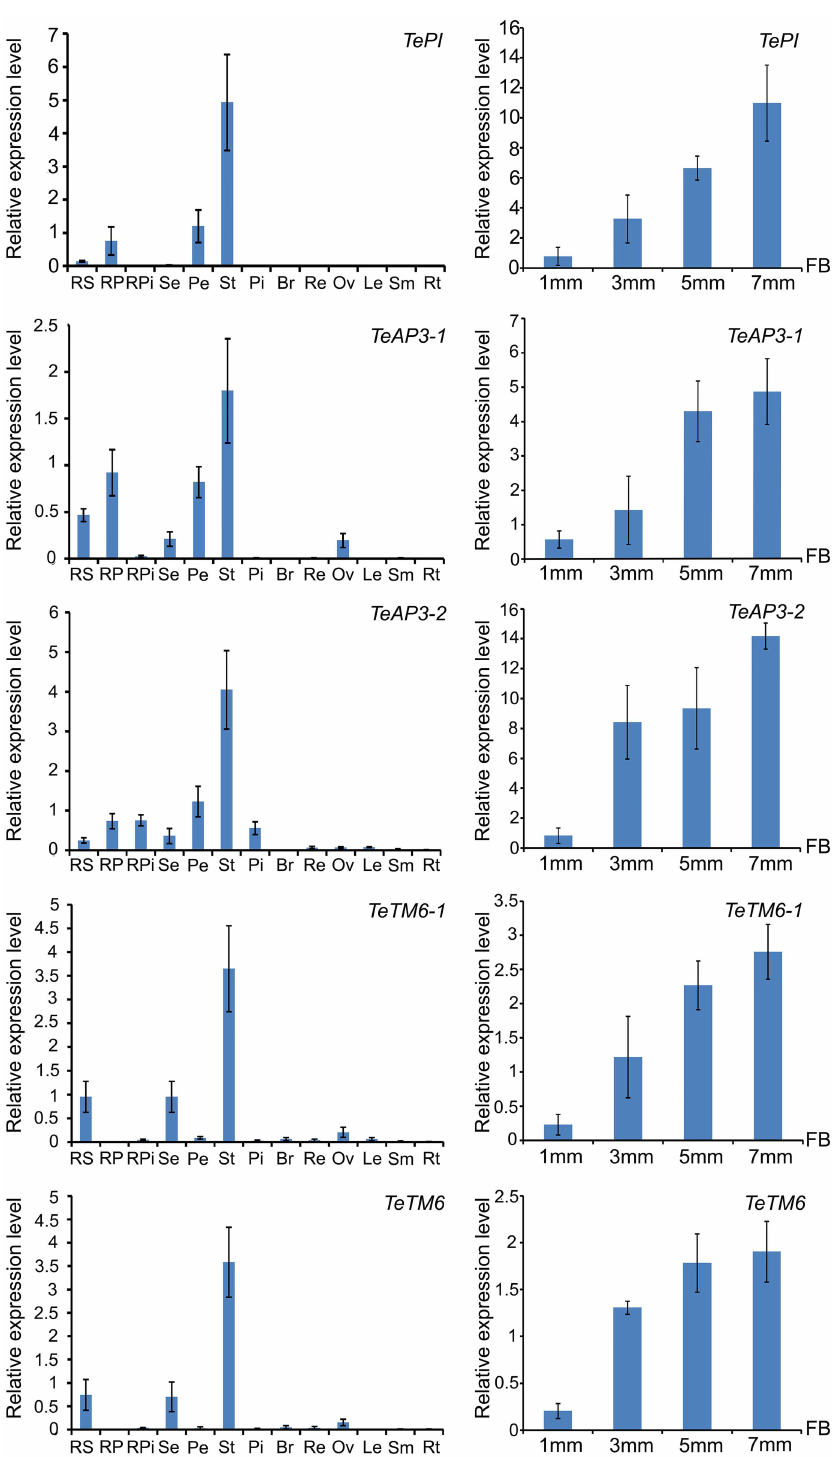
Fig 4. Expression levels of B class genes in different tissues, organs and different development stages of flower buds of T . erecta . The relative expressionlevel showedthat strong expressionof TePI was detected in stamens of disk florets, and weak expressionin petals of disk and ray florets along with little expressionin sepals of ray florets and no expressionwas detected in pistils of ray florets, sepals of disk floret, bracts, receptacles and vegetative organs. TeAP3-1 was expressedin sepals and petals of ray and